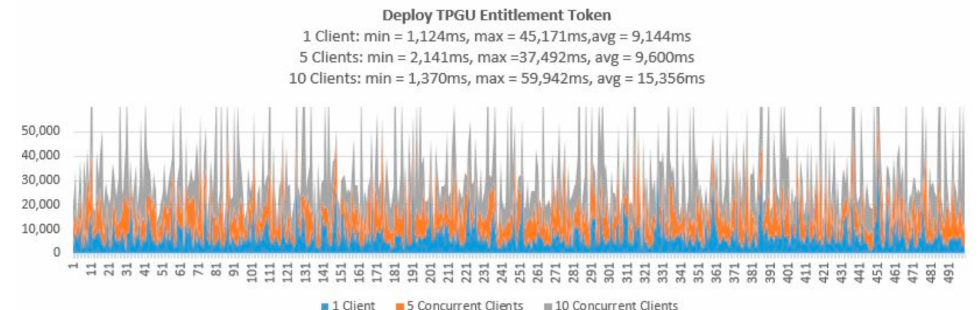
Figure 16. Response times from Deploy TPGU Entitlement Tokens for 500 calls.